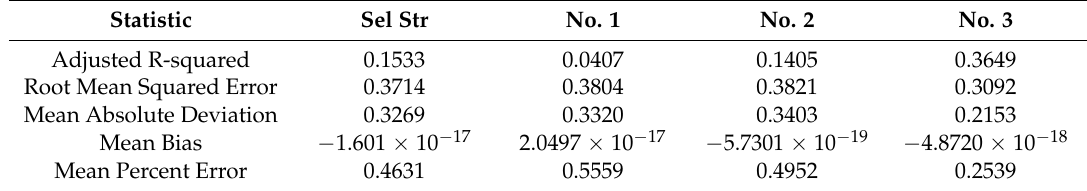
Table 10. Summary of the fit statistics for the two-equation structural grade model sets by visual grade.